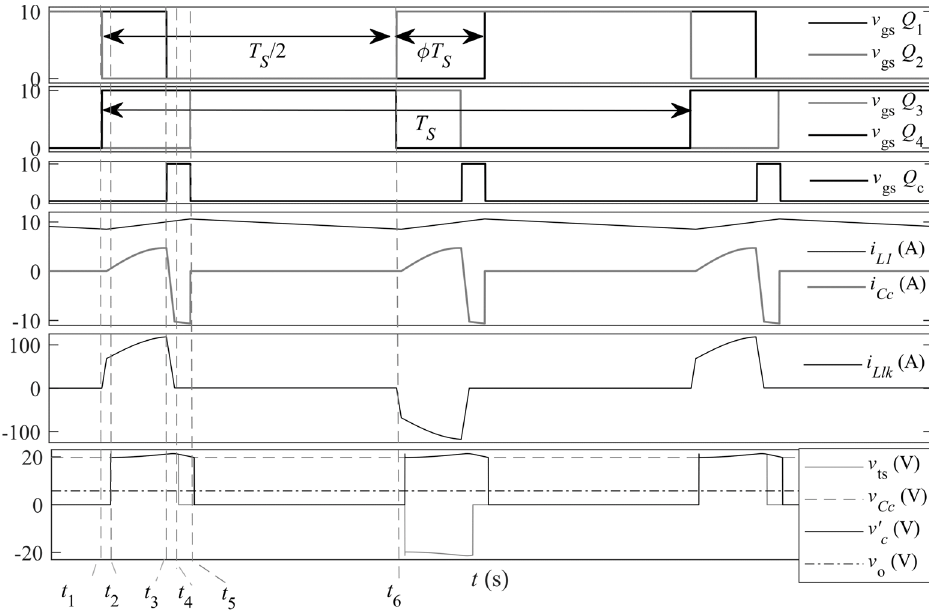
Figure 4. Buck-mode waveforms.